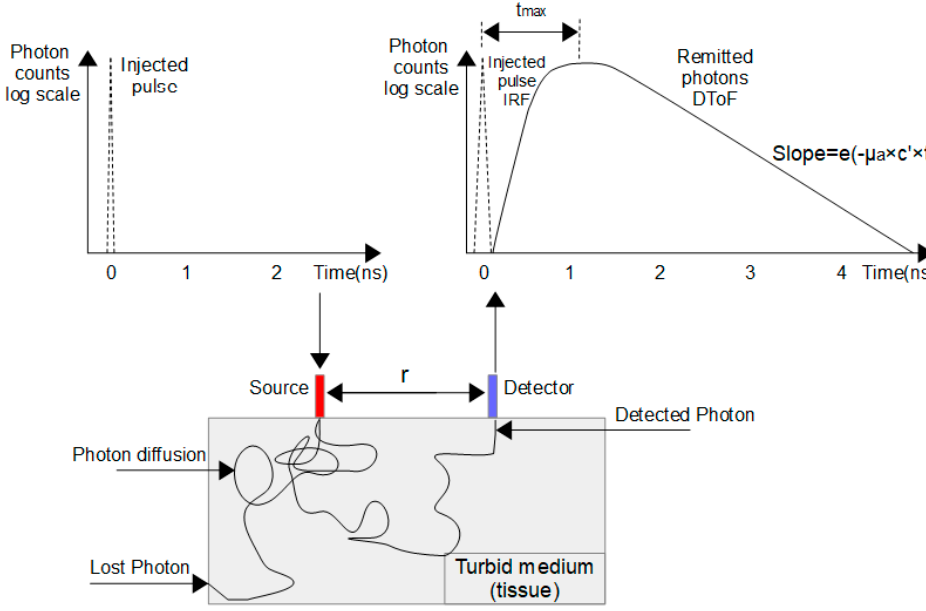
Figure 4. Recovering the optical properties of time-resolved diffuse reflectance measurement for a homogenous target.